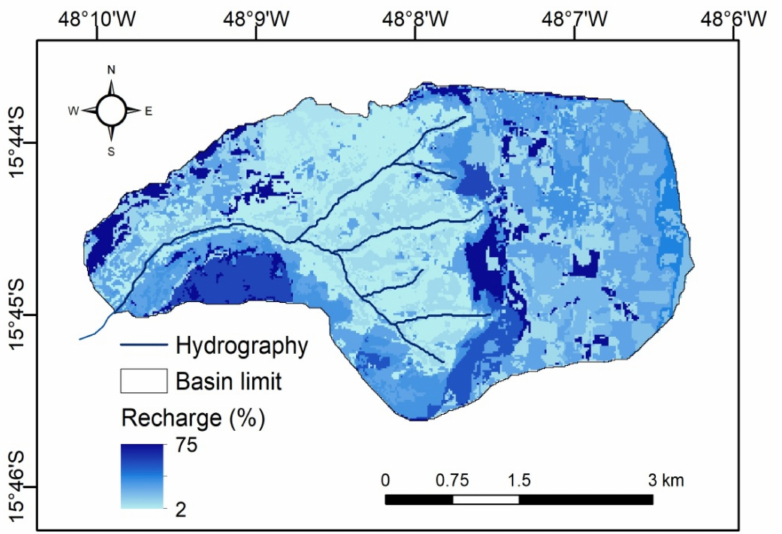
Figure 8. Estimated spatial distribution of effective groundwater recharge in the study area based on numerical modeling (% annual